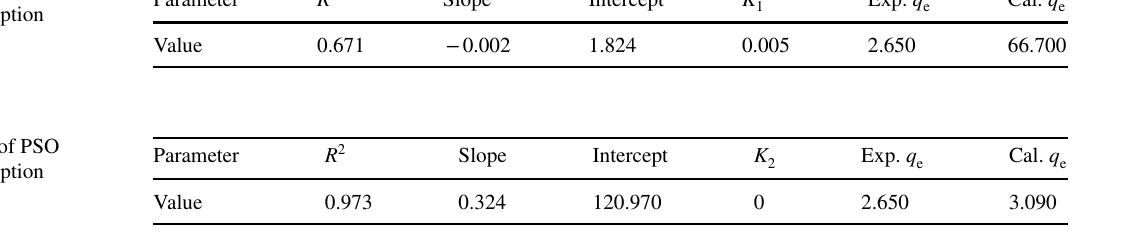
Table 6 Constants of PFO model for the adsorption process